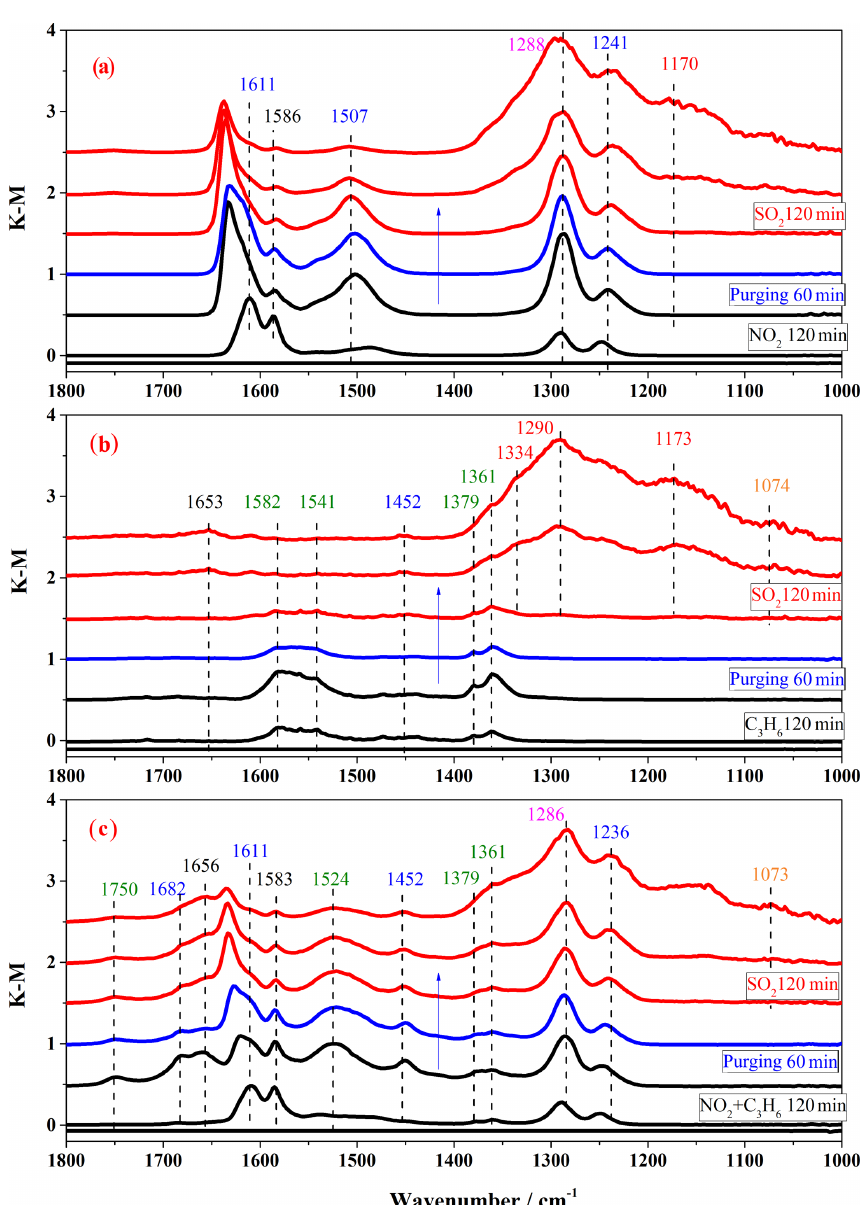
Figure 4. In situ DRIFTS spectra of surface products on TiO 2 in the step-by-step exposure experiments with irradiation: (a) exposure to 200ppmNO 2 for 2h (black lines), after purging 1h (blue line), and then to 200ppmSO 2 for 2h (red lines); (b) exposure to 200ppmC 3 H 6 for 2h (black lines), after purging 1h (blue line), and then to 200ppmSO 2 for 2h (red lines); (c) exposure to 200ppmNO 2 + 200ppmC 3 H 6 for 2h (black lines), after purging 1h (blue line), and then to 200ppmSO 2 for 2h (red